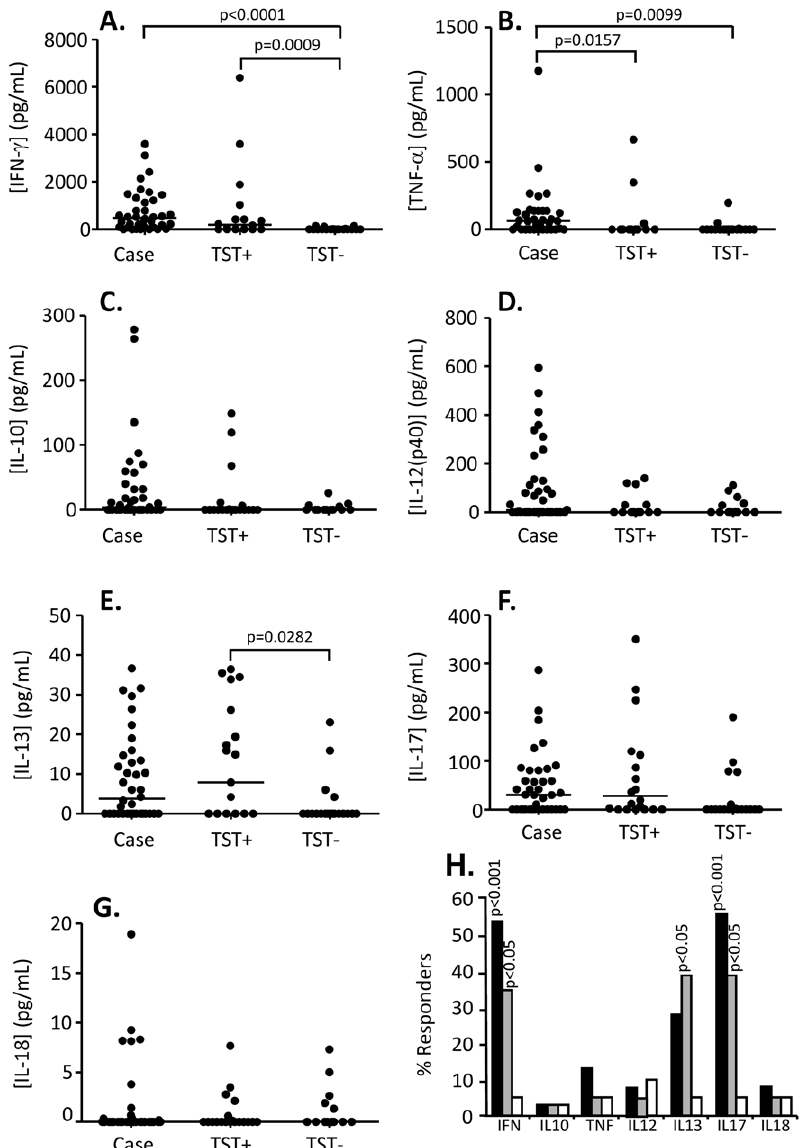
Figure 2. Cytokine responses following EC stimulation. Whole blood from TB cases (n=36), TST + (n=20) and TST 2 (n=19) contacts was stimulated for 7 days with ESAT-6/CFP-10 fusion protein and the supernatant assessed by multiplex cytokine analysis. A) IFN- c . B) TNF- a , C) IL-10, D) IL-12(p40), E) IL-13, F) IL-17 and G) IL-18. Line indicates median. Data were analysed using Tweedie distributions with p-values indicating significant differences after adjustment for age and sex. H) Percentage of responders (prior to adjustment for age and sex) producing IFN- c , IL-10, TNF- a , IL-12, IL-13, IL-17, IL-18. Dark bars=cases, grey bars=TST + contacts, white bars=TST 2 contacts; p-values are indicated and refer to comparison with TST 2 contacts. doi:10.1371/journal.pone.0012365.g002 contacts while analysis of TNF- a , IL-12(p40) and IL-17 in (Table 1). Following PPD stimulation, analysis of IFN- c alone combination increased this to 85% mainly due to an increase in resulted in 74% correct classification into TB cases and TST + specificity from 44% to 61% with sensitivity increasing from 92% HHC (Table 1). Combined analysis of IL-12(p40) and IL-13 to 97%. Thus our data shows enhanced classification if analysis is resulted in lower sensitivity (89% compared to 94% for IFN- c performed with multiple cytokines. ROC analysis determined a alone) but increased specificity (56%) resulting in 77% correct cut-off for active TB disease of TNF- a . 166pg/mL, IL-12(p40) classification (Table 1). Analysis of TNF- a , IL-12(p40) and IL-13 . 210pg/mL and IL-17 . 26pg/mL respectively. together resulted in 81% correct classification; sensitivity was 94% Multivariate analysis was also performed to attempt to classify and specificity was 56%. Following EC stimulation, analysis of IL- TST + and TST 2 HHC. We found that the level of % correct 12(p40) alone resulted in 81% correct classification and there was classification was lower for TST + and TST 2 contacts than for a slight decrease (to 79%) with addition of other cytokines differentiation between TB cases and TST + contacts suggesting (Table 1). Following TB10.4 stimulation, analysis of IFN- c alone that the 7-day assay we used is better for discriminating between resulted in 76% correct classification into TB cases or TST +